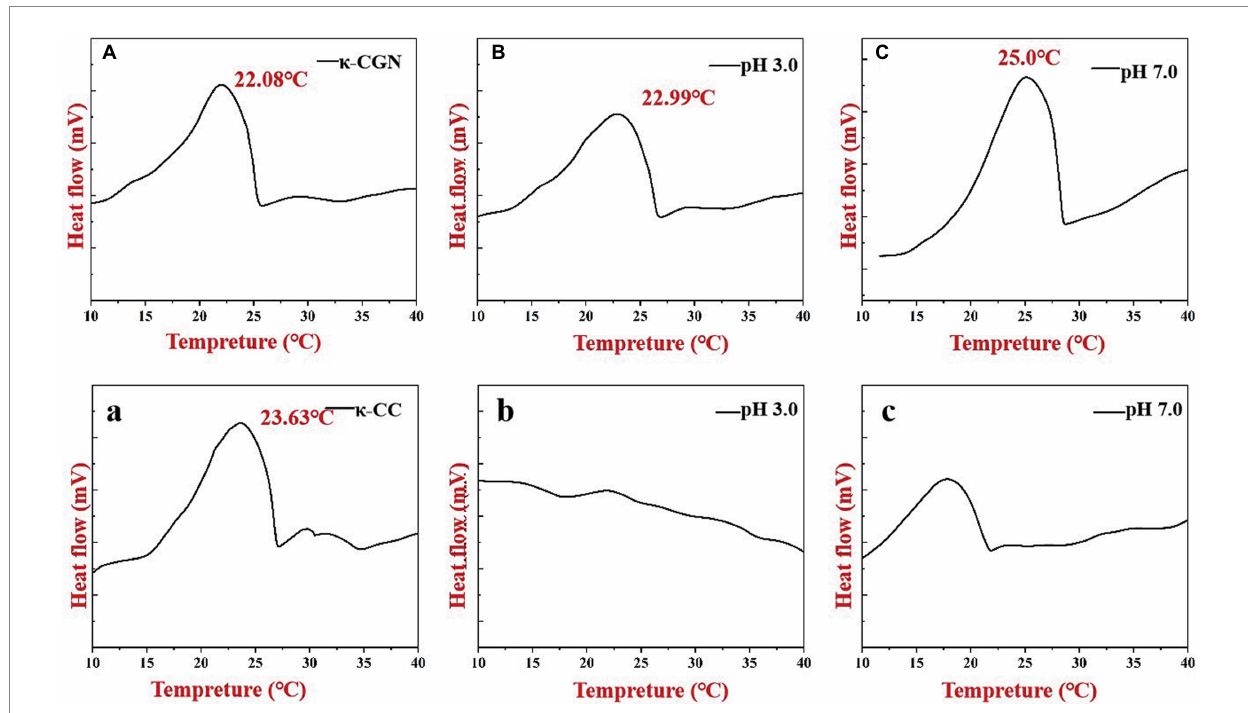
FIGURE 5 Heat flows of κ -CGN (A–C) and κ -CC complexes (a–c) at physiological pH in the simulated gastrointestinal phase upon